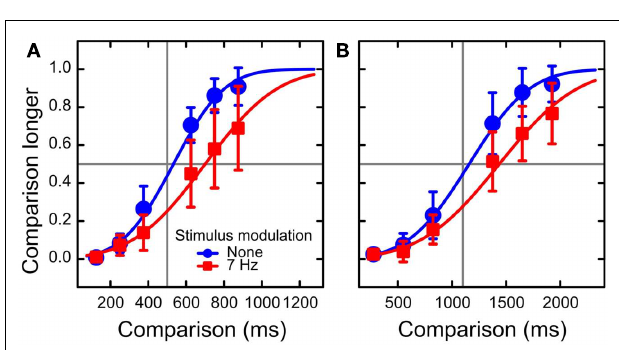
FIGURE 1 | Results of Experiment 1. (A) Dilation increased as a function of both modulation frequency and standard duration. (B) Dilation increased more when S2 (the second stimulus) was modulated than when S1 was